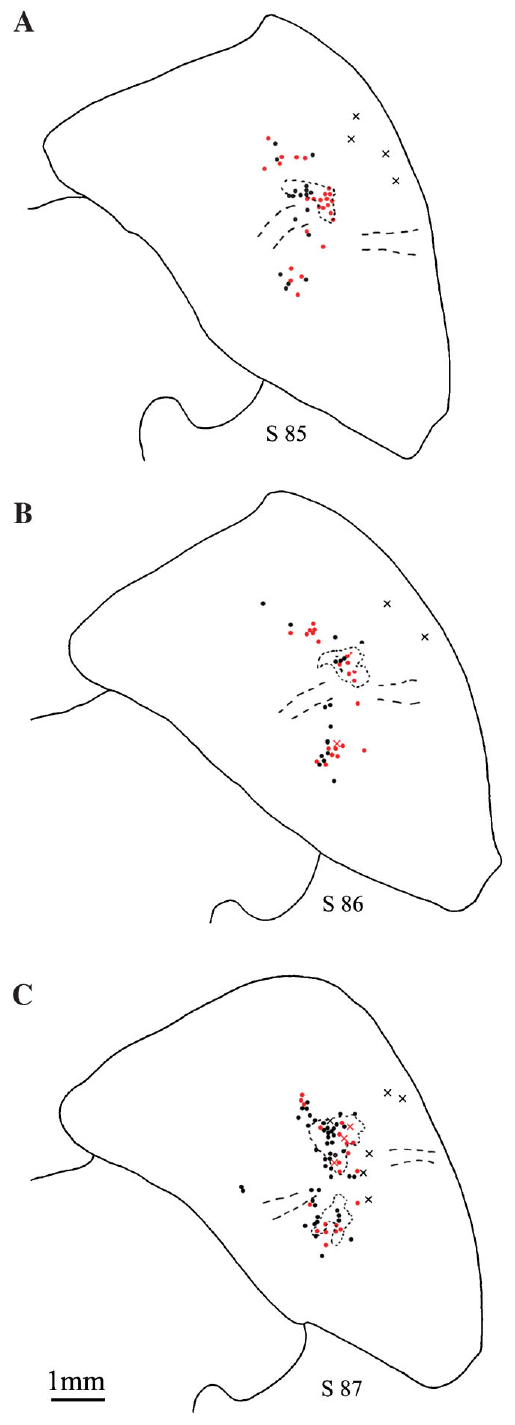
Figure 3. Distribution of pulvinocortical neurons . ( A – C ) Line drawings of the pulvinar from three sequential sections (s 85, 86, 87; case 109), showing the distribution of retrogradely labeled pulvinocortical neurons. Giant neurons (X) are few, usually isolated, and are often located laterally. Non-giant neurons are indicated by filled circles (1 circle or X = 1 neuron). A few of these occur away from the dense projection focus. BDA-labeled neurons are in black; AdSynEGFP-labeled neurons, in red; and concentrations of dense anterograde label (BDA only) are shown by dotted lines. Dashed lines indicate approximate location of corticotectal tract. Medial is to the